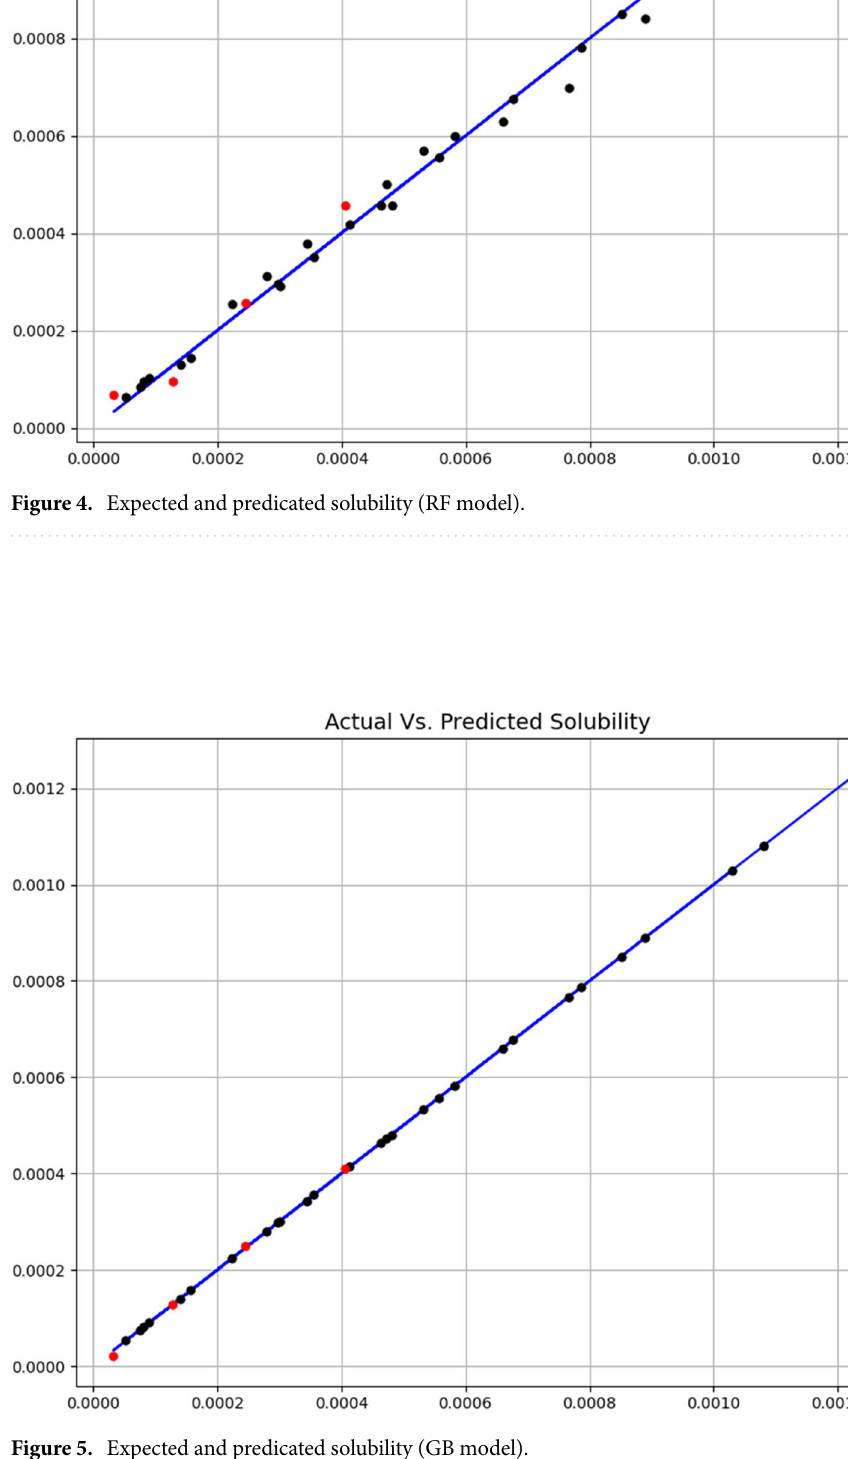
Figure 5. Expected and predicated solubility (GB